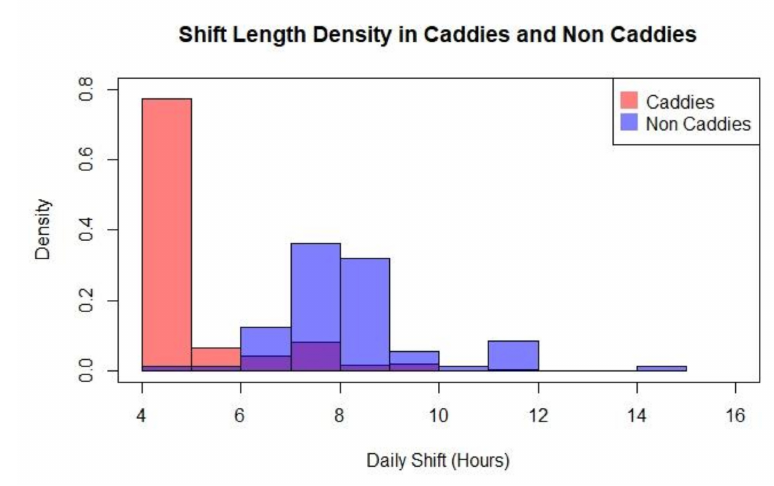
Figure 1. Shift Length Density in Caddies and Non-Caddies.